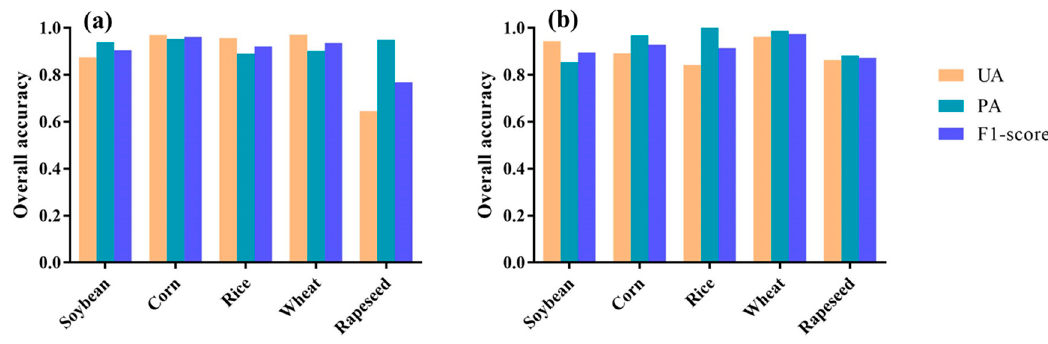
Figure 7. The classification accuracy of different crop types in ( a ) 2017 and ( b ) 2018.